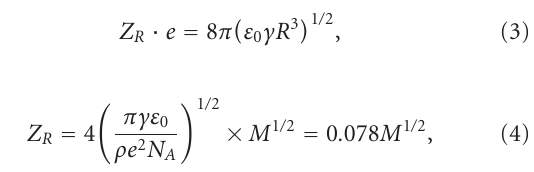
corresponding analyte (starburst dendrimers) [71]. The “ a